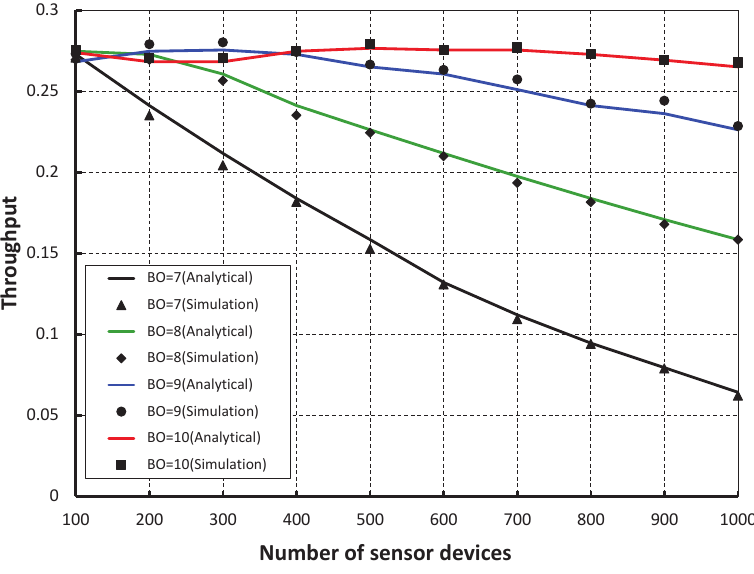
Figure 8. Validation of throughput for different beacon